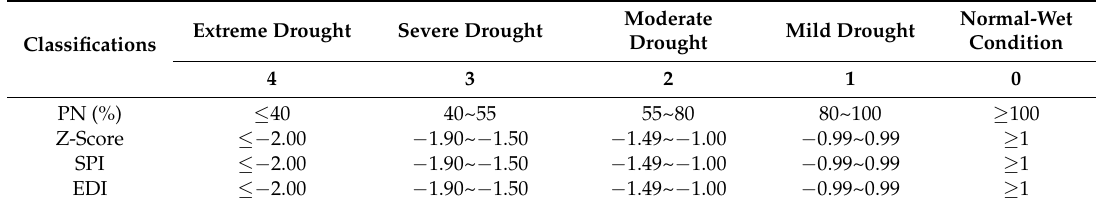
Table 3. Classifications of droughts for different